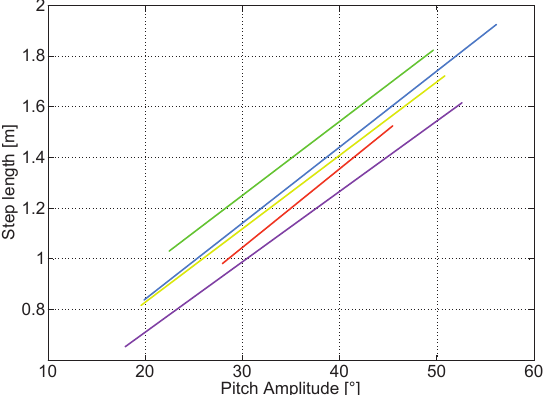
Figure 8. Regression lines of five volunteers walking at different speeds between 2.5 km/h and 6.5